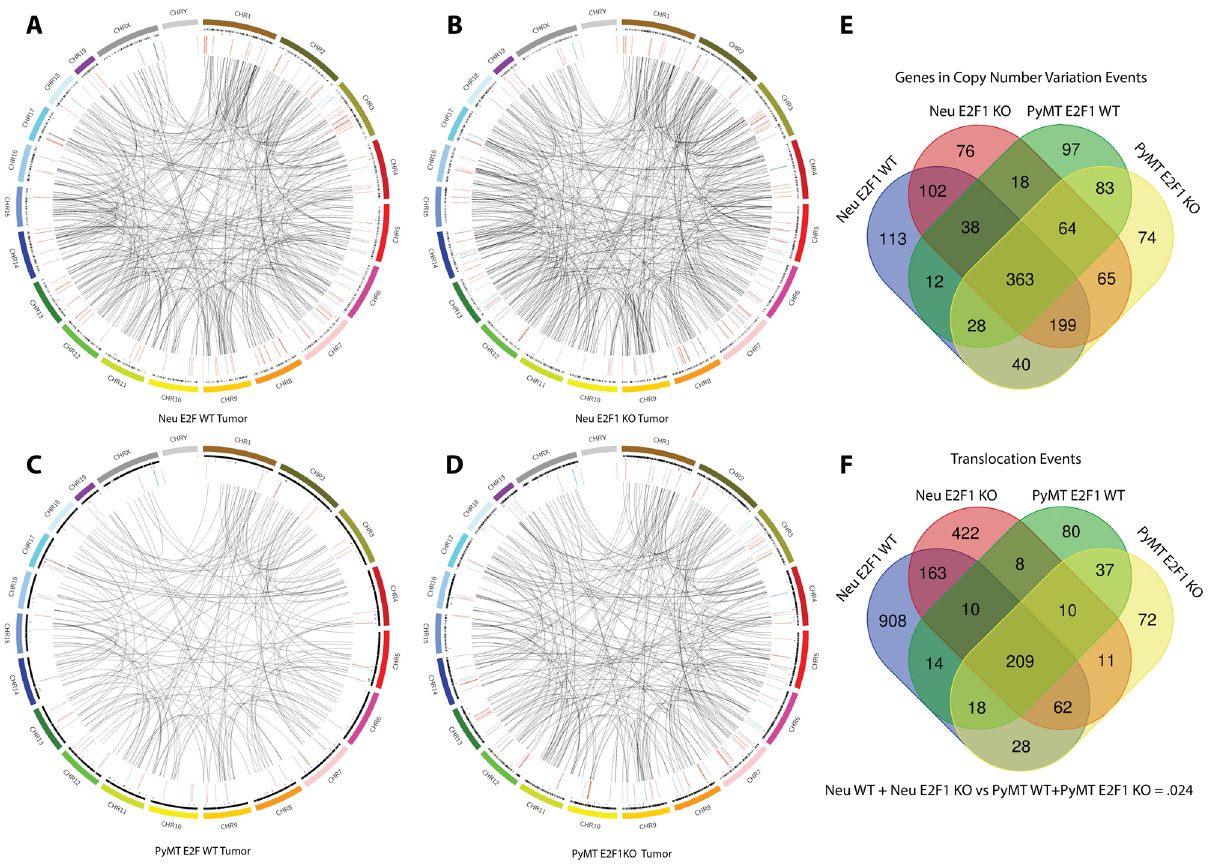
Figure 5. Mutation burden in Neu and PyMT tumors. ( A ) Circos plot for a representative Neu E2F1 +/+ sample. ( B ) Circos plot for a representative Neu E2F1 −/− sample. ( C ) Circos plot for a representative PyMT E2F1 +/+ sample. ( D ) Circos plot for a representative PyMT E2F1 −/− sample. For ( A )–( D ) Circos plots, outer most ring represents the mouse chromosomes. Four successive inner rings represent the following mutation types; total SNVs, exonic SNVs, Copy number variation with green being amplification and red being